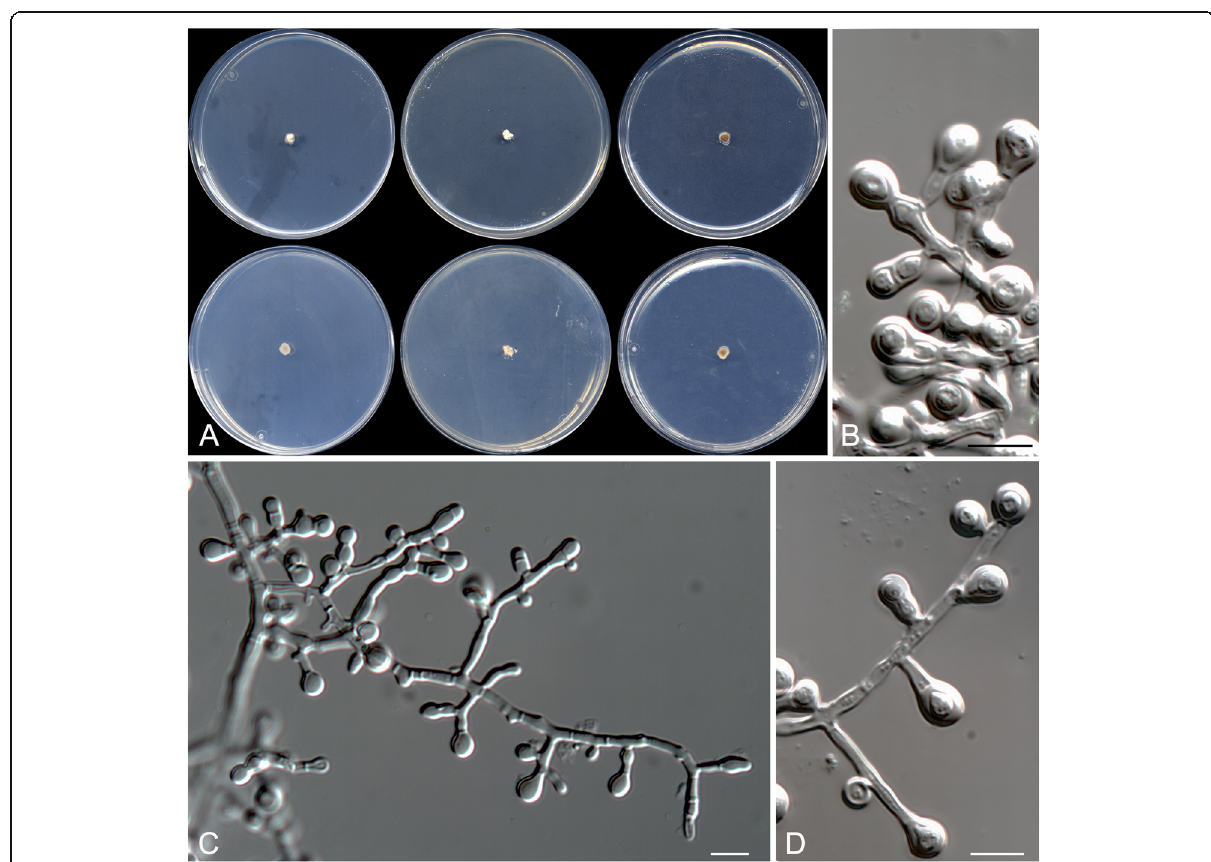
Fig. 11 Skoua asexualis CBS 144072 T . a Colonies on G18, MEA and PDA at 25 °C (left to right), surface and reverse (from top to bottom). b – d Conidiophores and conidia. Scale bar = 10 μ